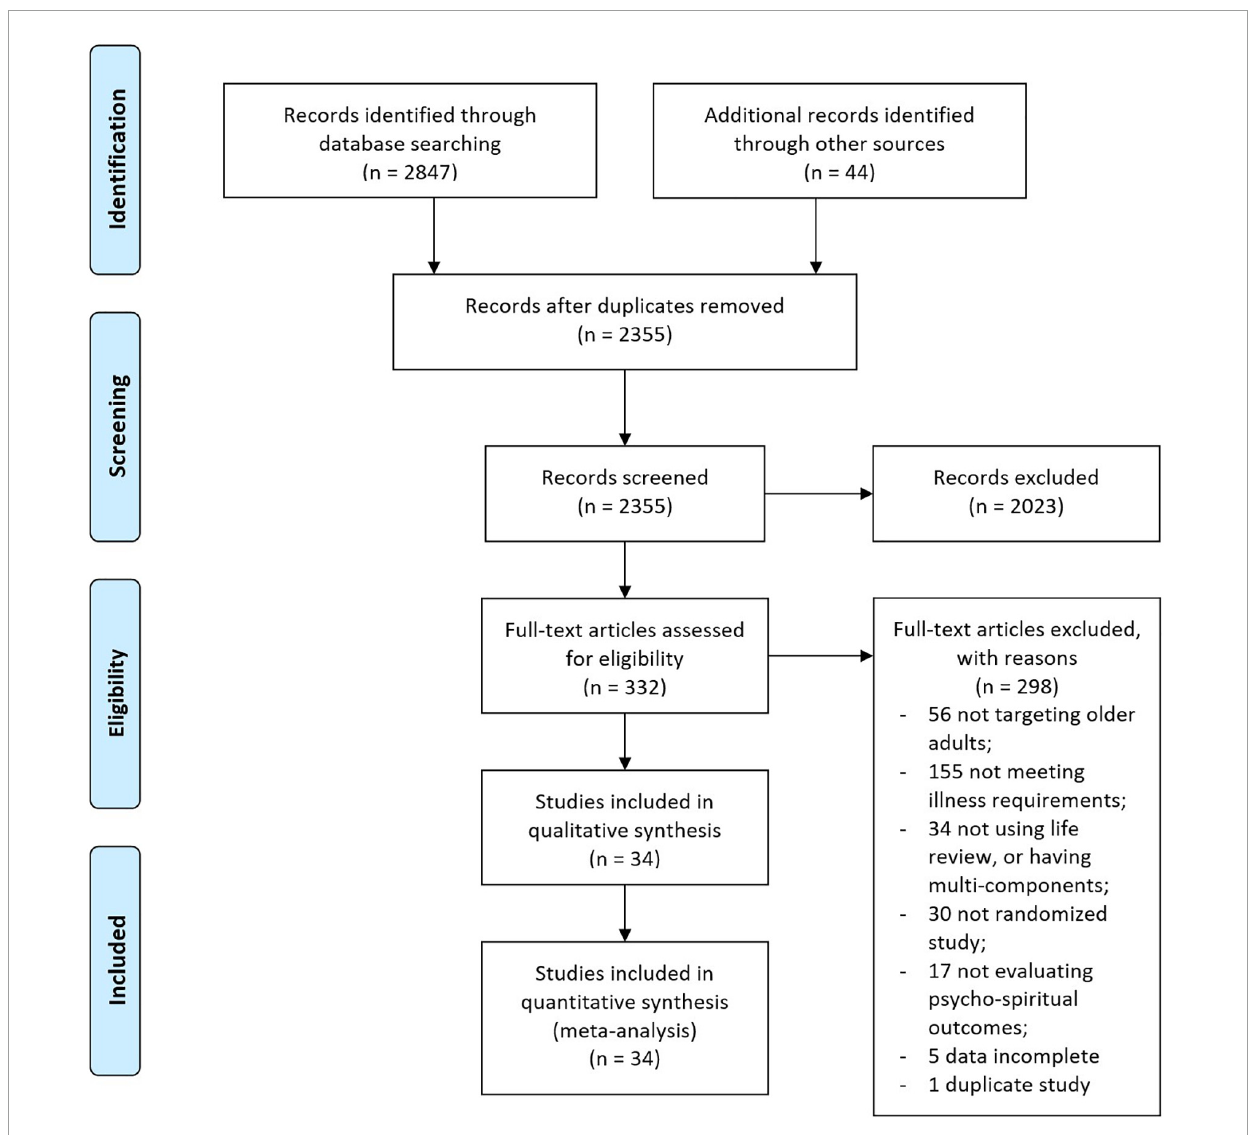
FIGURE1 Flowchart of the study selection